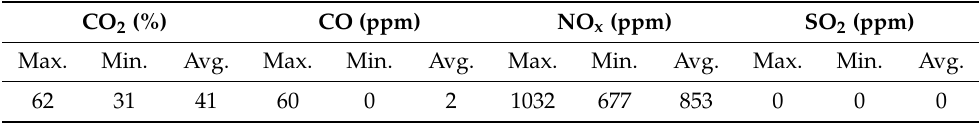
Table 8. Air pollutant concentrations in the exhaust gas.